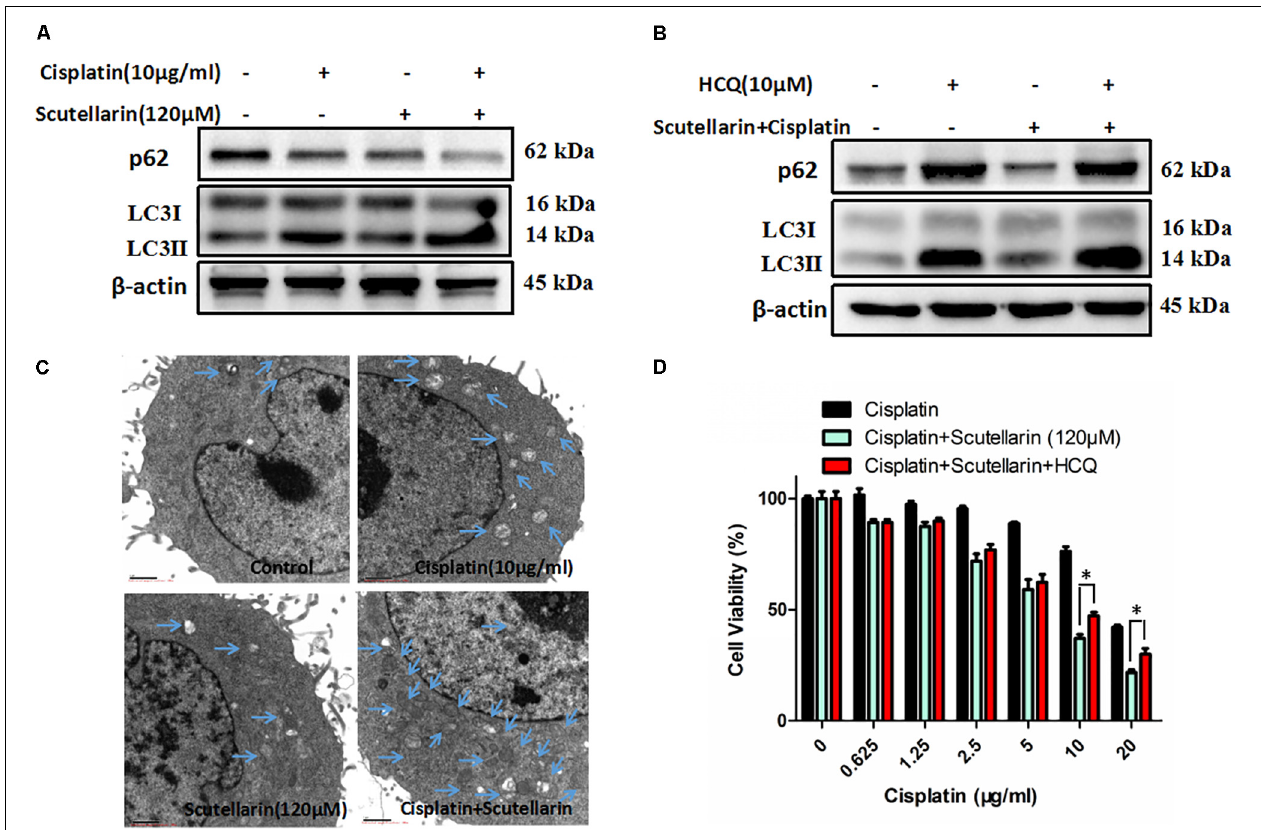
FIGURE 4 | Scutellarin increased cisplatin-induced autophagy. (A) A549/DDP cells were treated with the indicated concentrations of cisplatin or scutellarin, or the combination for 48 h, the expression of p62 and conversion of LC3-I to LC3-II were measured by western blotting. (B) Western blot analysis of p62 and LC3 in A549/DDP cells incubated with autophagy inhibitor HCQ. (C) Quantification of autophagic vacuoles in A549/DDP cells was analyzed by TEM. (D) The effect of HCQ on sensitivity of cisplatin and scutellarin was detected by MTT assay. Data are representative of three independent experiments (mean ± SEM). ∗ p < 0.05, ∗∗ p <